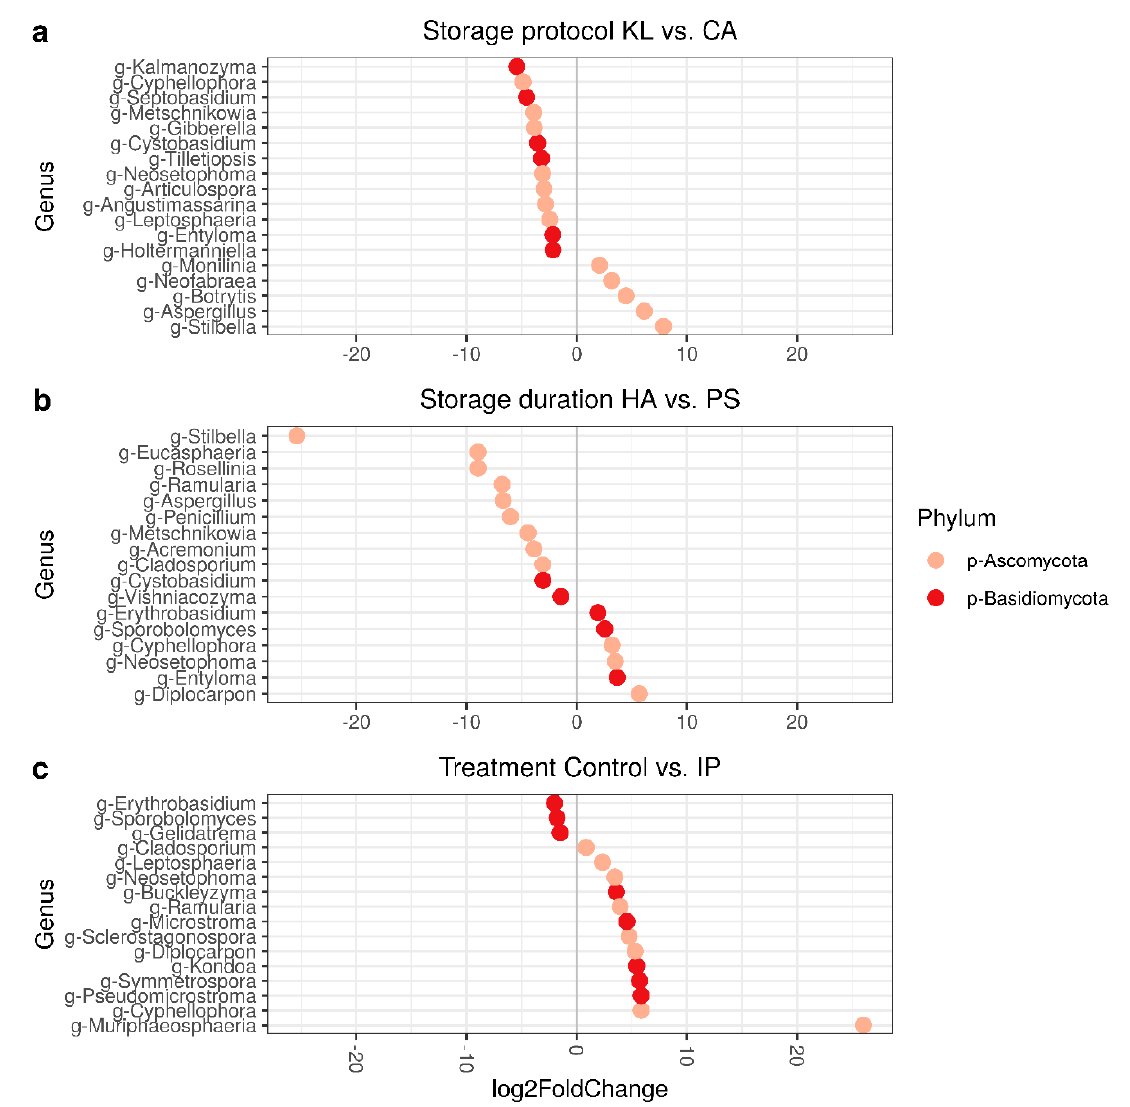
Figure 5. Differential abundance of microbial genera (log2 fold change): ( a ) storage under controlled atmosphere storage (CA) versus regular cold storage (KL); ( b ) storage duration for sample after shelf-life period (PS) versus samples at harvest (HA); ( c ) plant protection management treatments (IP) versus untreated control (C).